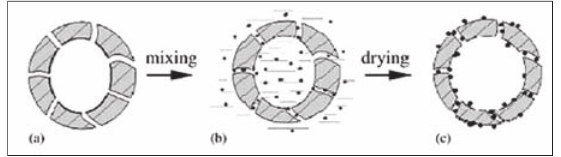
Fig. 13 Preparation of drug carrying for porous hol- low SiO 2 particles. (a) hollow SiO 2 particles; (b) suspension of BB and hollow particles; (c) BB entrapped in hollow particles 154) .